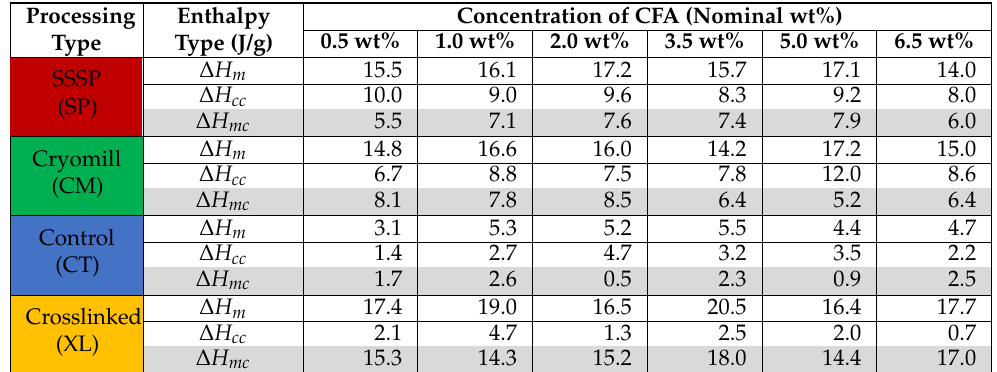
Table 1. Crystallization characteristics extrapolated from DSC first heat curves, with the top number in each cell being ∆ H m , the middle, subtracted number being ∆ H cc , and the resulting number (shaded) being ∆ H mc . Note: all values are reported in